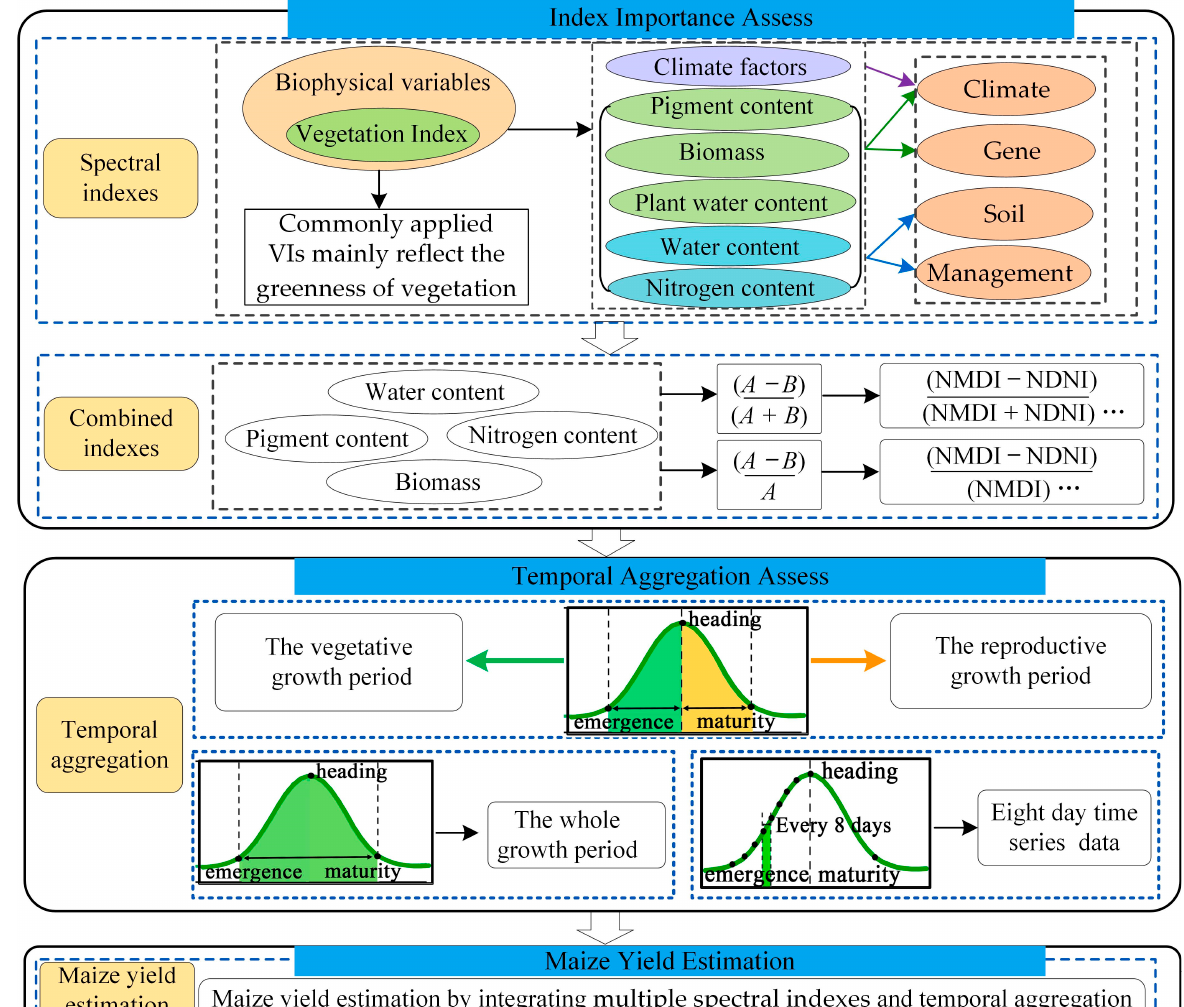
Figure 2. Proposed methodology of parameter (index) development for yield estimation.